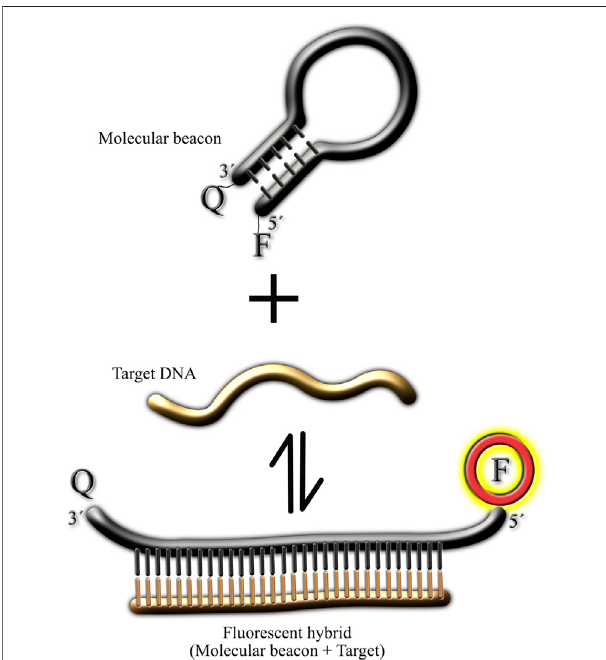
molecular beacons. The fi gure illustrates the molecular beacon in the non- fl uorescent state (hairpin) in the absence of the target. Upon target addition, the 3 ′ and 5 ′ ends of the molecular beacon separate from each other, resulting in light emission by the fl uorophore. In all the MB synthesized for this study the fl uorophore was at the 5 ′ end and the quencher at the 3 ′ end (Material and Methods).